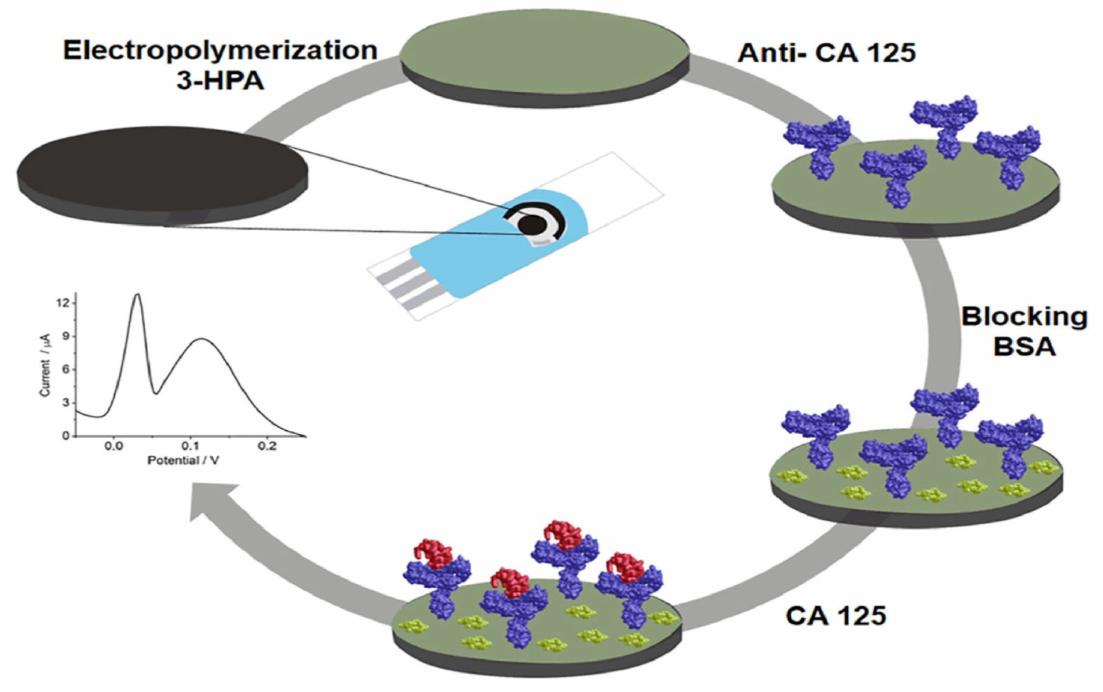
Figure 10. SPGE/poly(3–HPA)/anti–CA 125 Immunosensor construction process. Reprinted